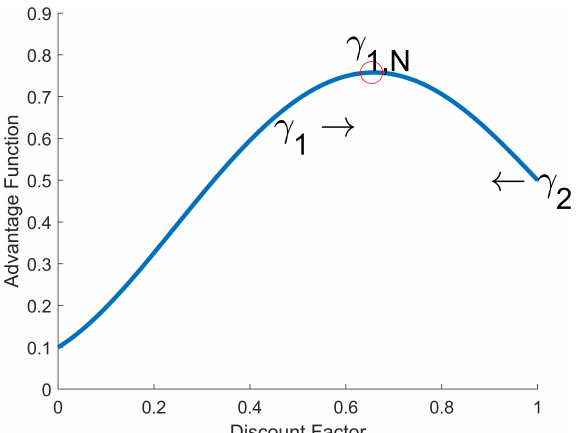
Figure 5. Example of discount factor adjustment using the adaptive discount